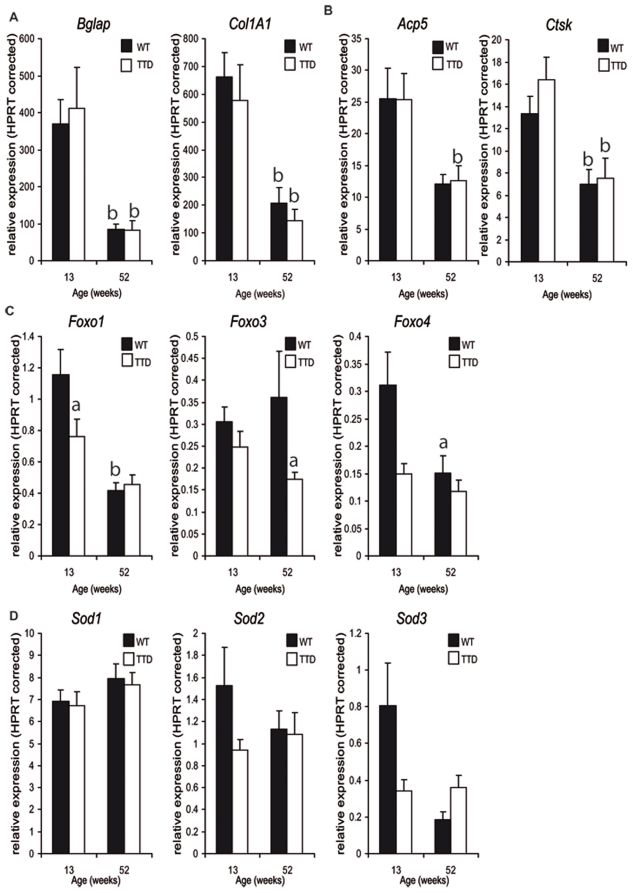
Regulation of gene expression levels in tibiae.Expression levels measured in RNA extracted from tibiae of 13 and 52 week old wild type and TTD mice; (A) osteoblast marker genes Bglap and Col1A1. (B) Osteoclast marker genes Acp5 and Ctsk, (C) stress regulated genes Foxo1, Foxo3 and Foxo4, (D) antioxidant enzyme scavengers Sod1, Sod2 and Sod3. Statistics: student t-test a = p<0.05 wild type vs. TTD, b = p<0.05 time point x vs. time point 13 weeks within one genotype.